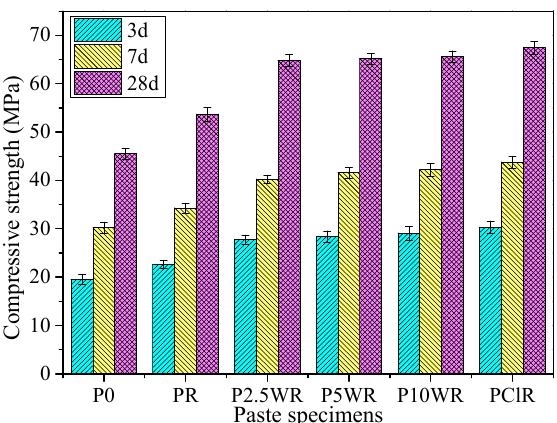
Figure 9. Compressive strength as a function of age for RHA cement paste.